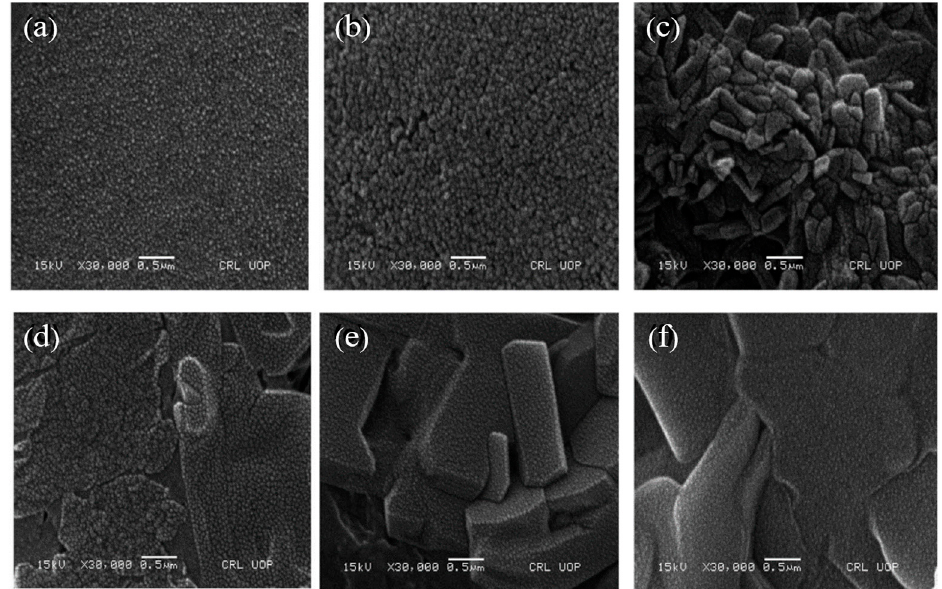
Figure 10. SEM micrographs of hybrid ( a ) P(MAA)-Cu, ( b ) P(MAA)-Ni, ( c ) P(APTMACI)-Cu, ( d ) P(APTMACI-Ni, ( e ) P(AAm)-Cu, and, ( f ) P(AAm)-Ni hydrogels [155].